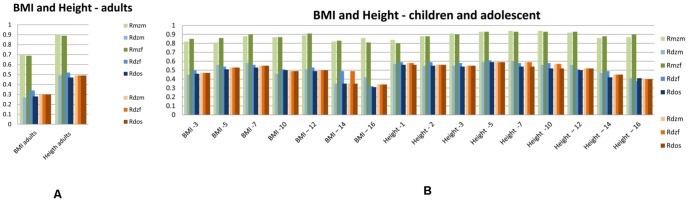
Twin correlations for BMI and Height.1A: adult twins and 1B: adolescent twins. The green bars represent correlations in Monozygotic Male (MZM) twin pairs (light green) and Monozygotic Female (MZF) twin pairs. The blue bars represent correlations in Dizygotic Male (DZM) twin pairs, Dizygotic Female (DZF) twin pairs and Dizygotic Opposite Sex (DOS) twin pairs. The green and blue bars reflect the correlations in a full model, while the orange bars reflect twin correlations for Dizygotic (DZ) twin pairs in the most parsimonious model, with: DZM (light orange), MZF (normal orange), DOS (dark orange).